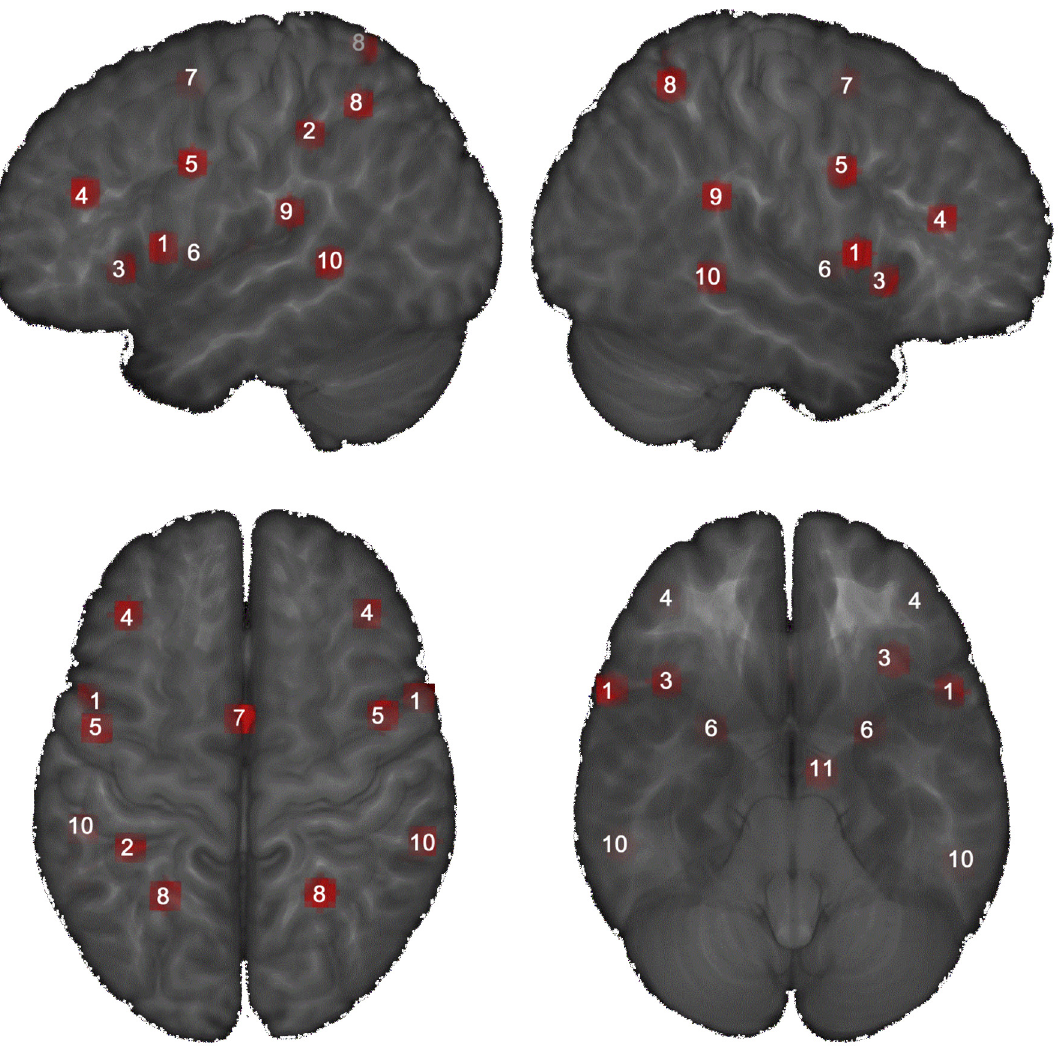
Fig 2. An overview of the motor imagery network based on the meta-analyzes of Hétu and colleagues (2013). MNI-peak coordinates are surrounded by a 6mm-sphere. Views: sagital and axial. 1 Inferior Frontal Gyrus (IFG), bilateral; 2 Inferior Parietal Lobule (IPL), left; 3 Insula, bilateral; 4 Middle Frontal Gyrus (MFG), bilateral; 5 Precentral Gyrus (M1), bilateral; 6 Putamen, bilateral; 7 Supplementary Motor Area (SMA), left; 8 Superior Parietal Lobule (SPL), bilateral; 9 Supramarginal Gyrus (SMG), bilateral; 10 Superior Temporal Sulcus (STS/STG), bilateral; 11 Thalamus,